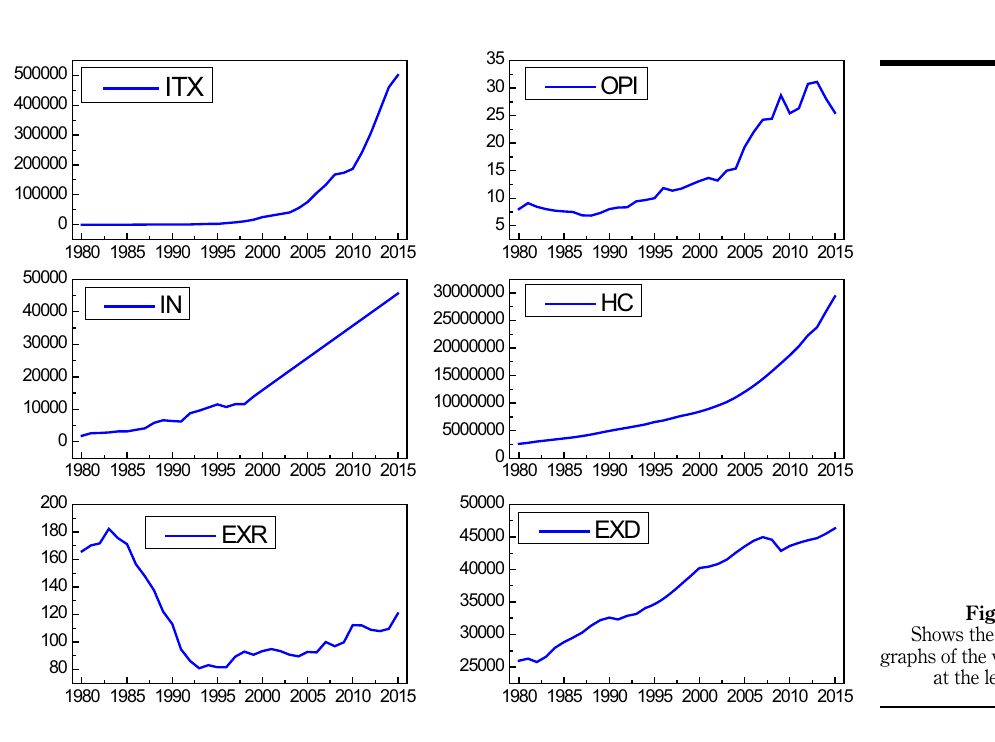
Figure A1. Shows the multiple graphs of the variables at the level